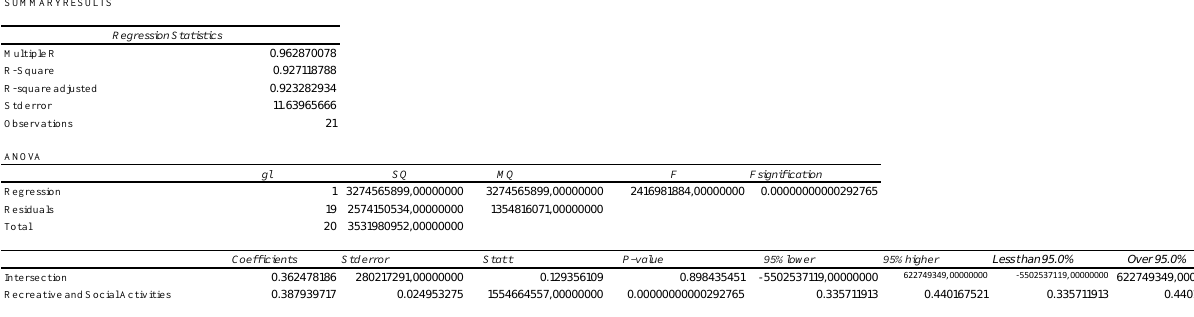
Figure 7. The linear progression for the residents’ participation in recreational and social activity. The linear progression for the use of social networks was around 86.1% (see Figure 8). This means that after the end of the COVID-19 pandemic, the possibility of using social networks again was 86.1%.